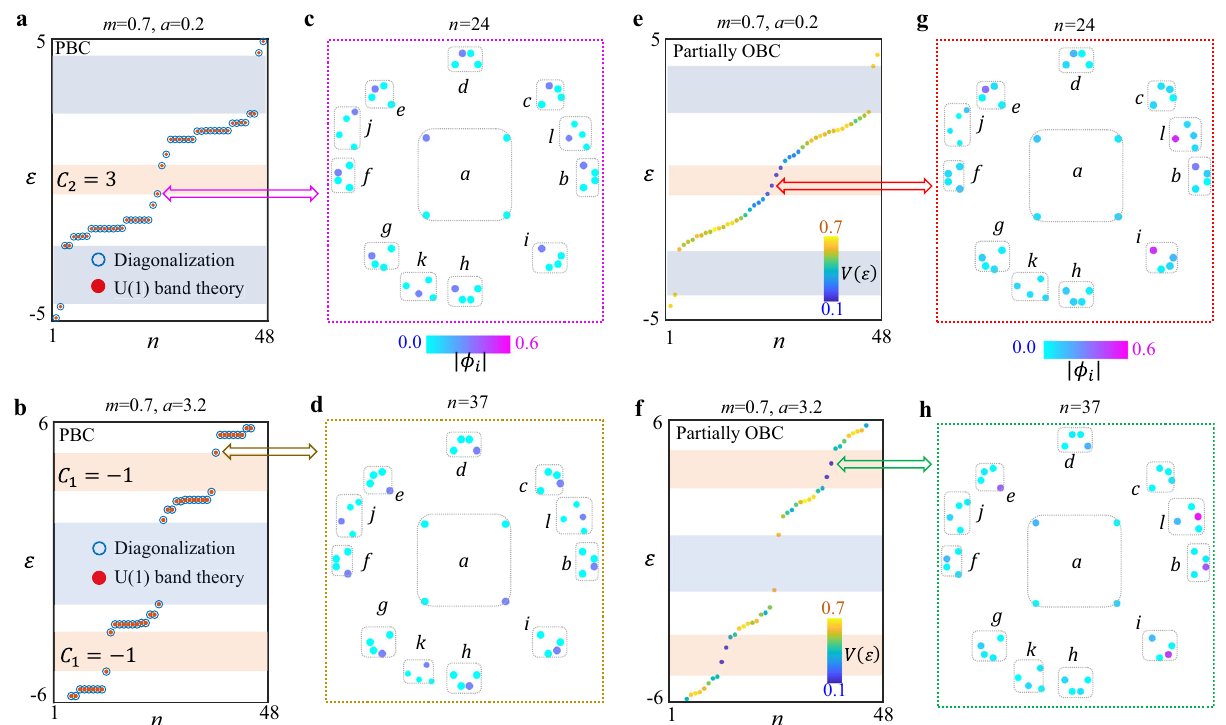
Fig. 2 | Numerical results of fi nite hyperbolic clusters with PBCs and partially OBCs. a , b The eigen-spectra of hyperbolic abelian clusters under PBCs, and the mass terms are ( m =0.7, a =0.2) and ( m =0.7, a =3.2). The blue circleand red dots correspond to numerical results obtained by the direct diagonalization and U (1) hyperbolic band theory, respectively. c , d The spatial pro fi les of eigenmodes (marked by blue and orange arrows in Fig. 2a, b) for the topological hyperbolic clusters under PBCs with mass term being ( m =0.7, a =0.2) and ( m =0.7, a =3.2),